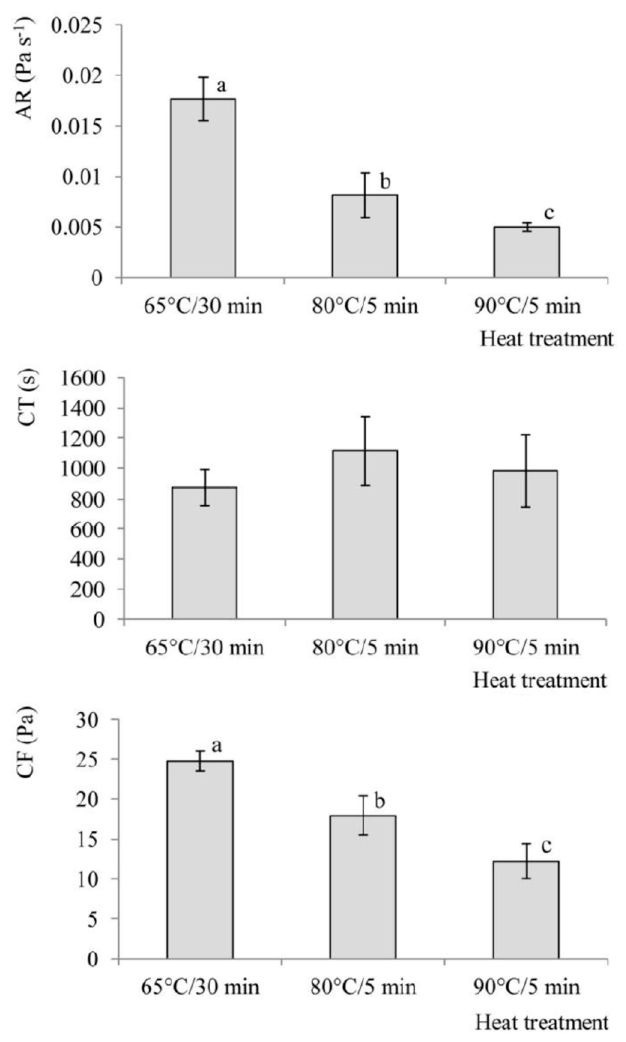
Figure 3. Rennet coagulation parameters: aggregation rate (AR), coagulation time (CT) and curd firmness (CF) of rennet gels from goat milk heated to 65 ◦ C / 30 min, 80 ◦ C / 5 min and 90 ◦ C / 5 min. (a,b,c) Values assigned with different letters differ significantly from one another ( p < 0.05); results in the graphs are the mean values of three replicates; error bars indicate standard deviations).